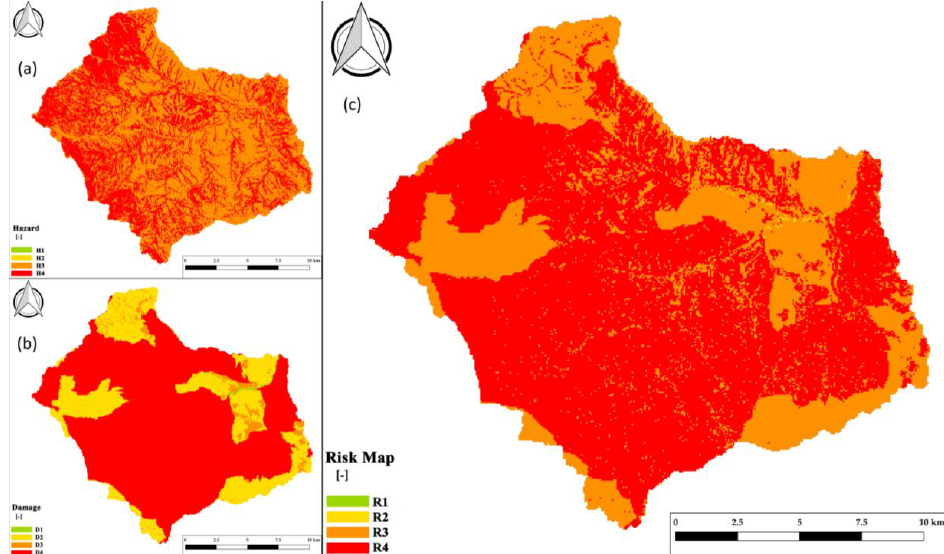
Figure 9. The product between the hazard map ( a ) and the damage map ( b ) is the risk map ( c ).